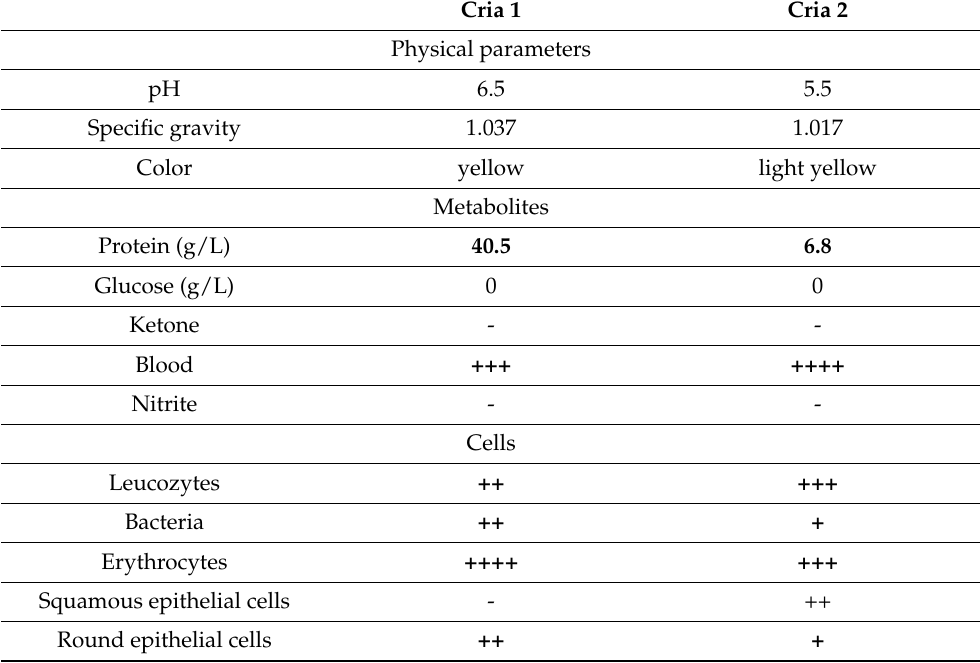
Table 3. Urine evaluation. pH level, protein, glucose, ketone, blood and nitrite were detected by Combur 9 Test ® , Roche Diagnostics AG, Rotkreuz, Switzerland. Specific gravity was detected by a refractometer and cells and crystals were evaluated microscopically from urine sediment after given semi-quantitatively (up to ++++). Values that differ from the references are displayed in